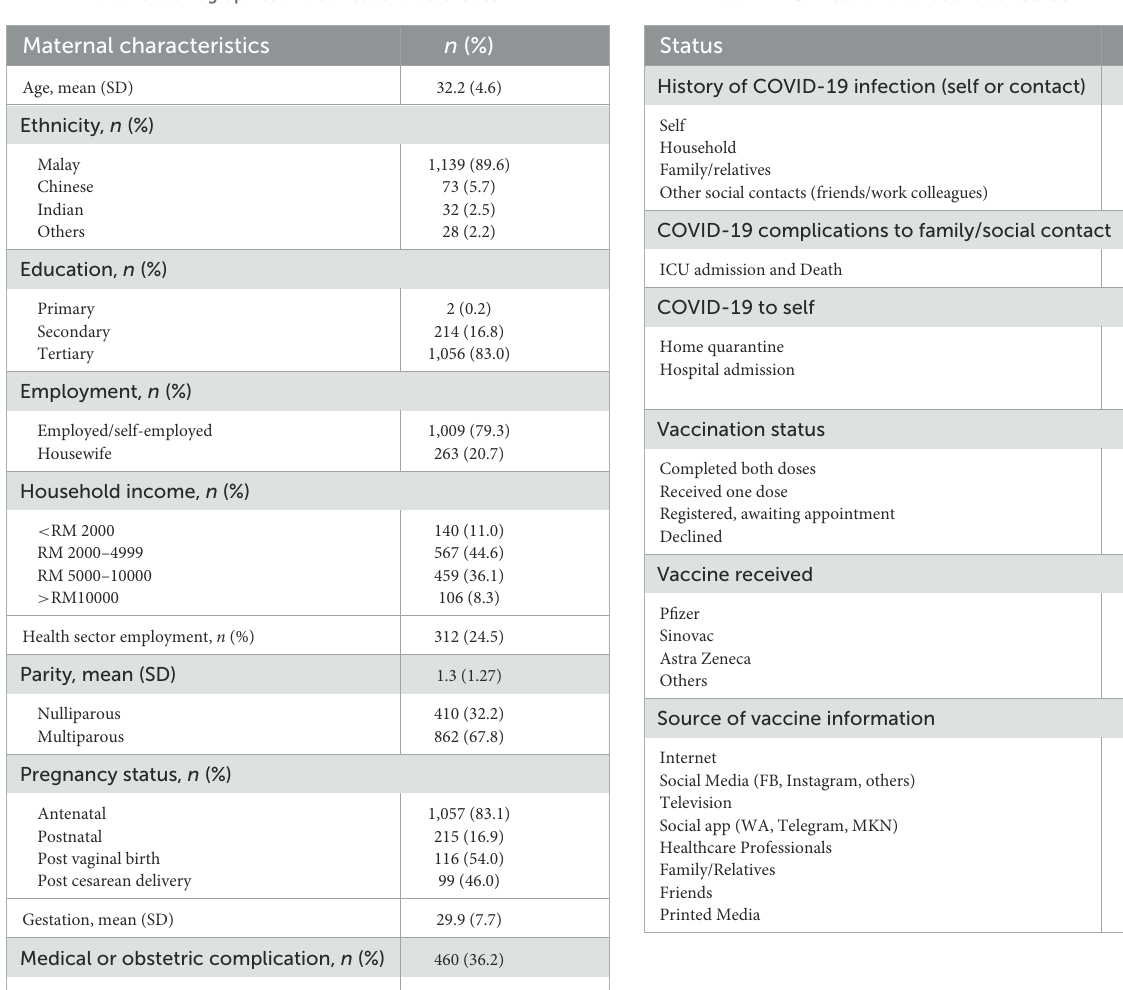
TABLE 1 Maternal demographics and clinical characteristics. TABLE 2 COVID-19 infection and vaccination